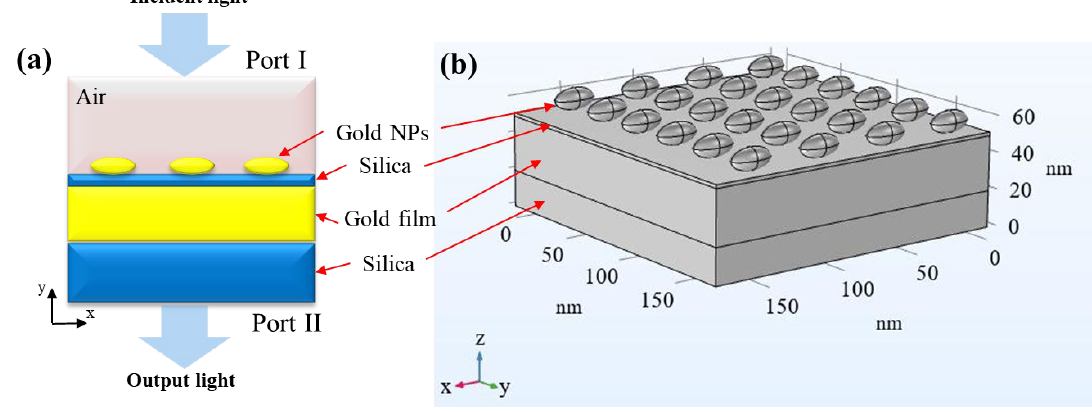
Figure 1. ( a ) 2D, ( b ) 3D schematic of the proposed plasmonic structure.